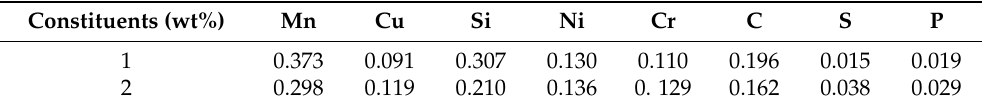
Figure 2. Schematic diagram of LIBS system. Table 2. Trace elements content of the two Q235 steel